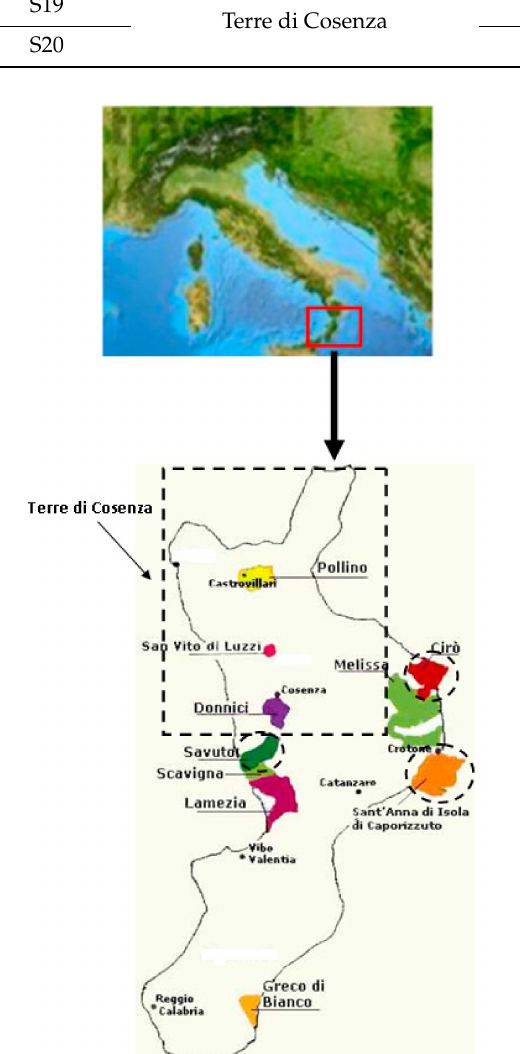
Figure 1. A map of all Calabrian DOCs (in di ff erent colors), with the investigated areas of origin enclosed in a dotted